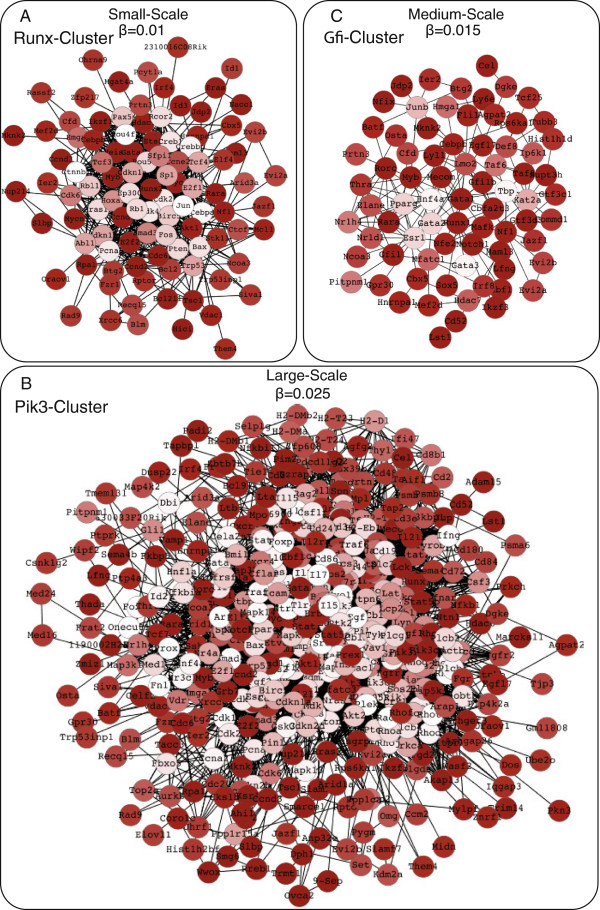
Prominent ReMIC gene clusters. ReMIC genes in the relevant diffusion scale of A) Runx-cluster (consisting of 100 ReMIC genes at the small-scale), B) Pik3-cluster (consisting of 436 ReMIC genes at the large-scale) and C) Gfi-cluster (consisting of 75 ReMIC genes at the medium-scale). The clusters are visualized using Organic Cytoscape layout [32]. The color of the nodes reflects the mutation score before diffusion.